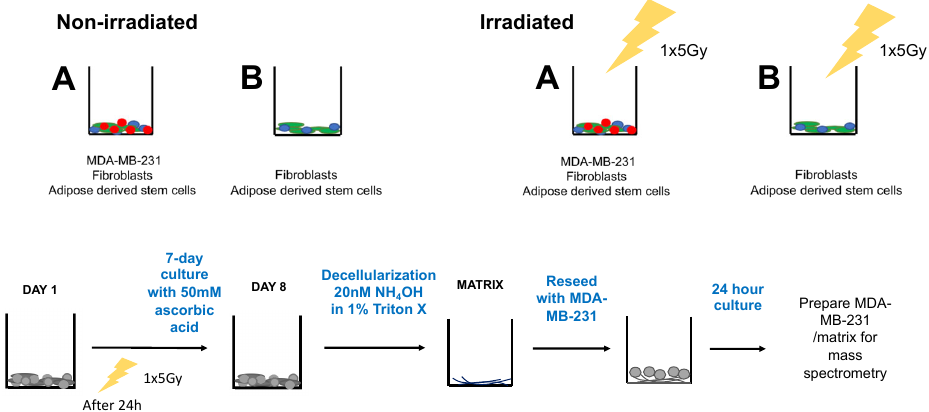
Figure 3. Schematic showing workflow for irradiated cell groups. Cells (group A and B) were seeded at DAY 1 and irradiated 24 h after with one dose of 5 Gy. Cells were cultured for one week, decellularized and recellularized with MDA ‐ MB ‐ 231. One day later, samples were prepared for mass spectroscopy. Group A: MDA ‐ MB ‐ 231, Fibroblasts, ASCs; B: Fibroblasts, ASCs.